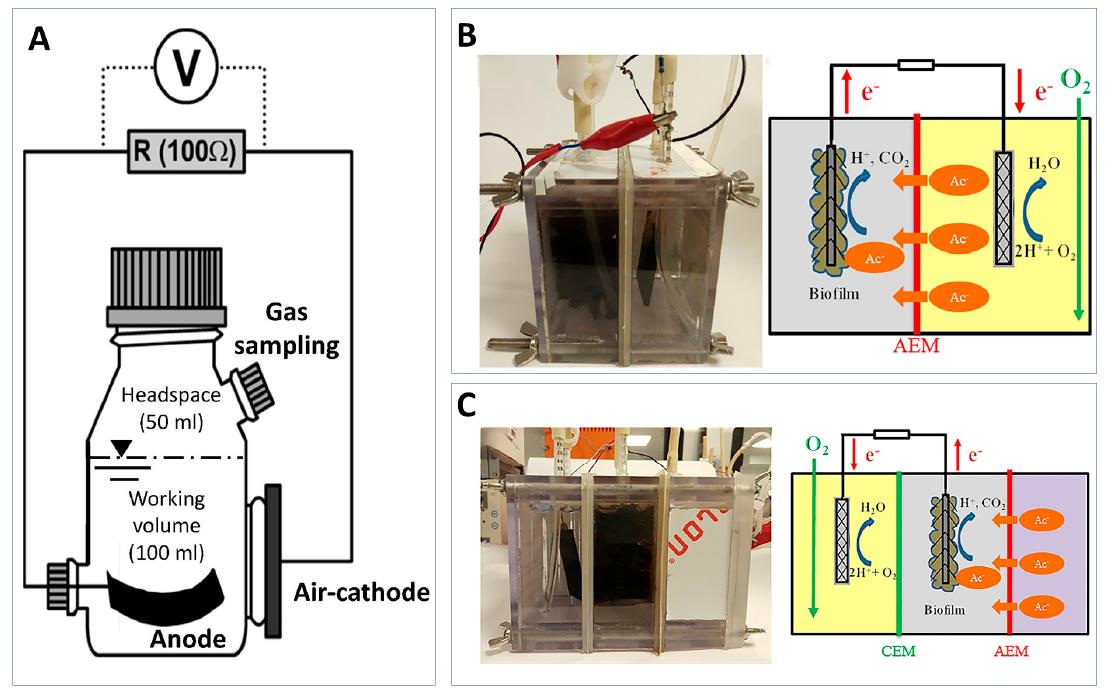
Figure 4. Summary of ( A ) Single-chambered [116], ( B ) double-chambered [117,121], and ( C ) three- chambered [118] MFCs for VFA detection.